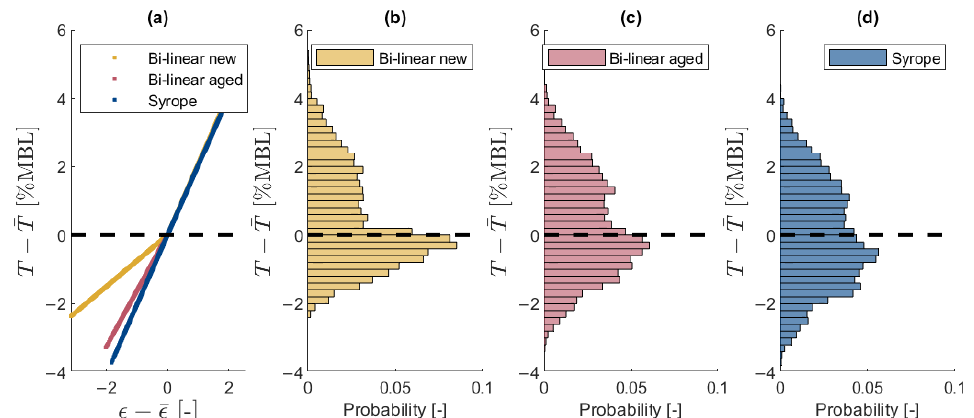
Figure 13. Sample dynamic tension time series for mooring line 1 under wind speed 24 m/s. The bi-linear and Syrope models show good agreement for tensions above ¯ T , while the tension amplitudes are reduced for the bi-linear model below ¯ T .